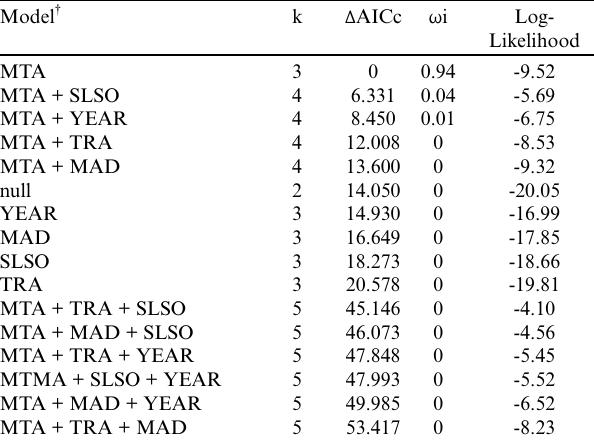
Table 1 . Ranking of models explaining variation in median spring arrival date of Ring-billed Gulls ( Larus delawarensis ) in southern Québec determined from Étude des Populations d’Oiseaux du Québec (EPOQ), 1971-2012. Model † k Δ AICc ω i Log-